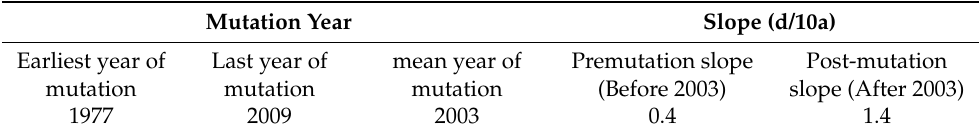
Table 2. Mann–Kendall test of maximum consecutive extreme maximum temperature event